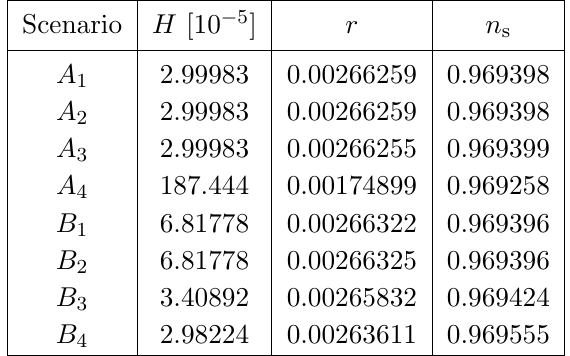
= 65, m A = 200 GeV. e